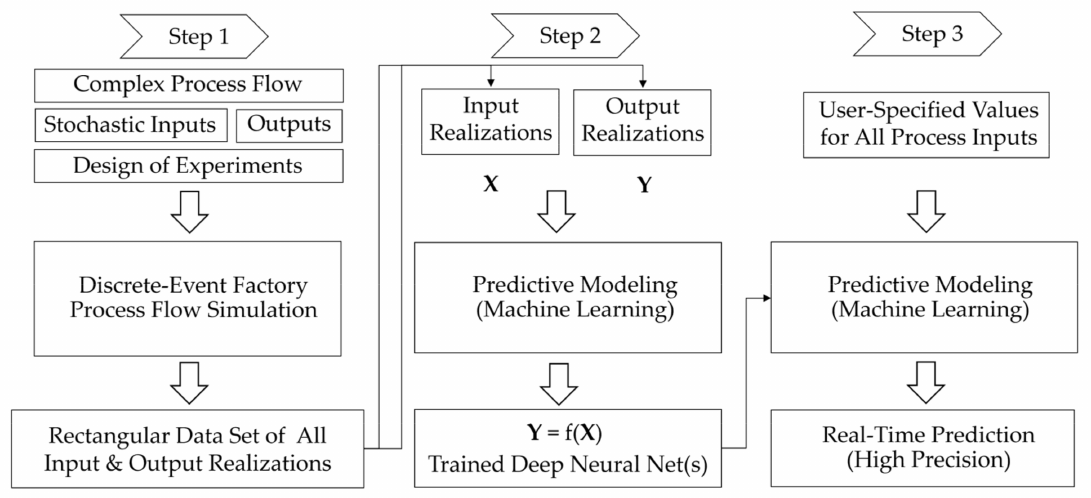
Figure 10. A three-step approach to predict factory KPIs in real time